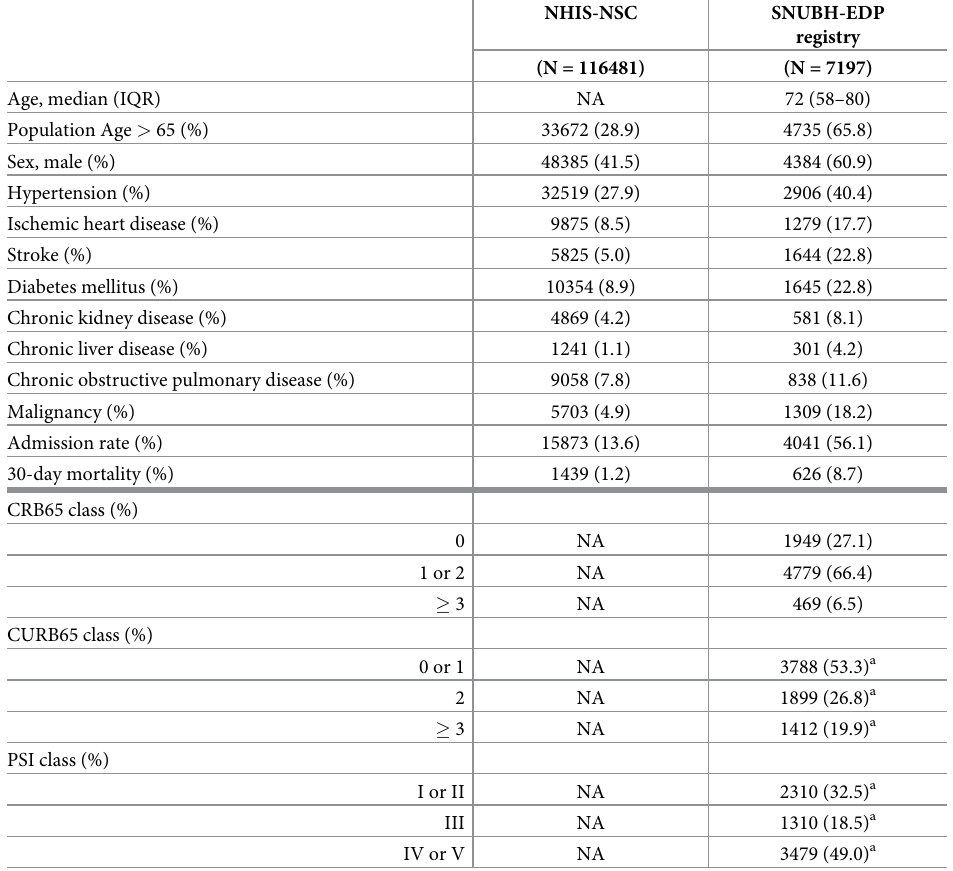
Table 1. Baseline characteristics of the study